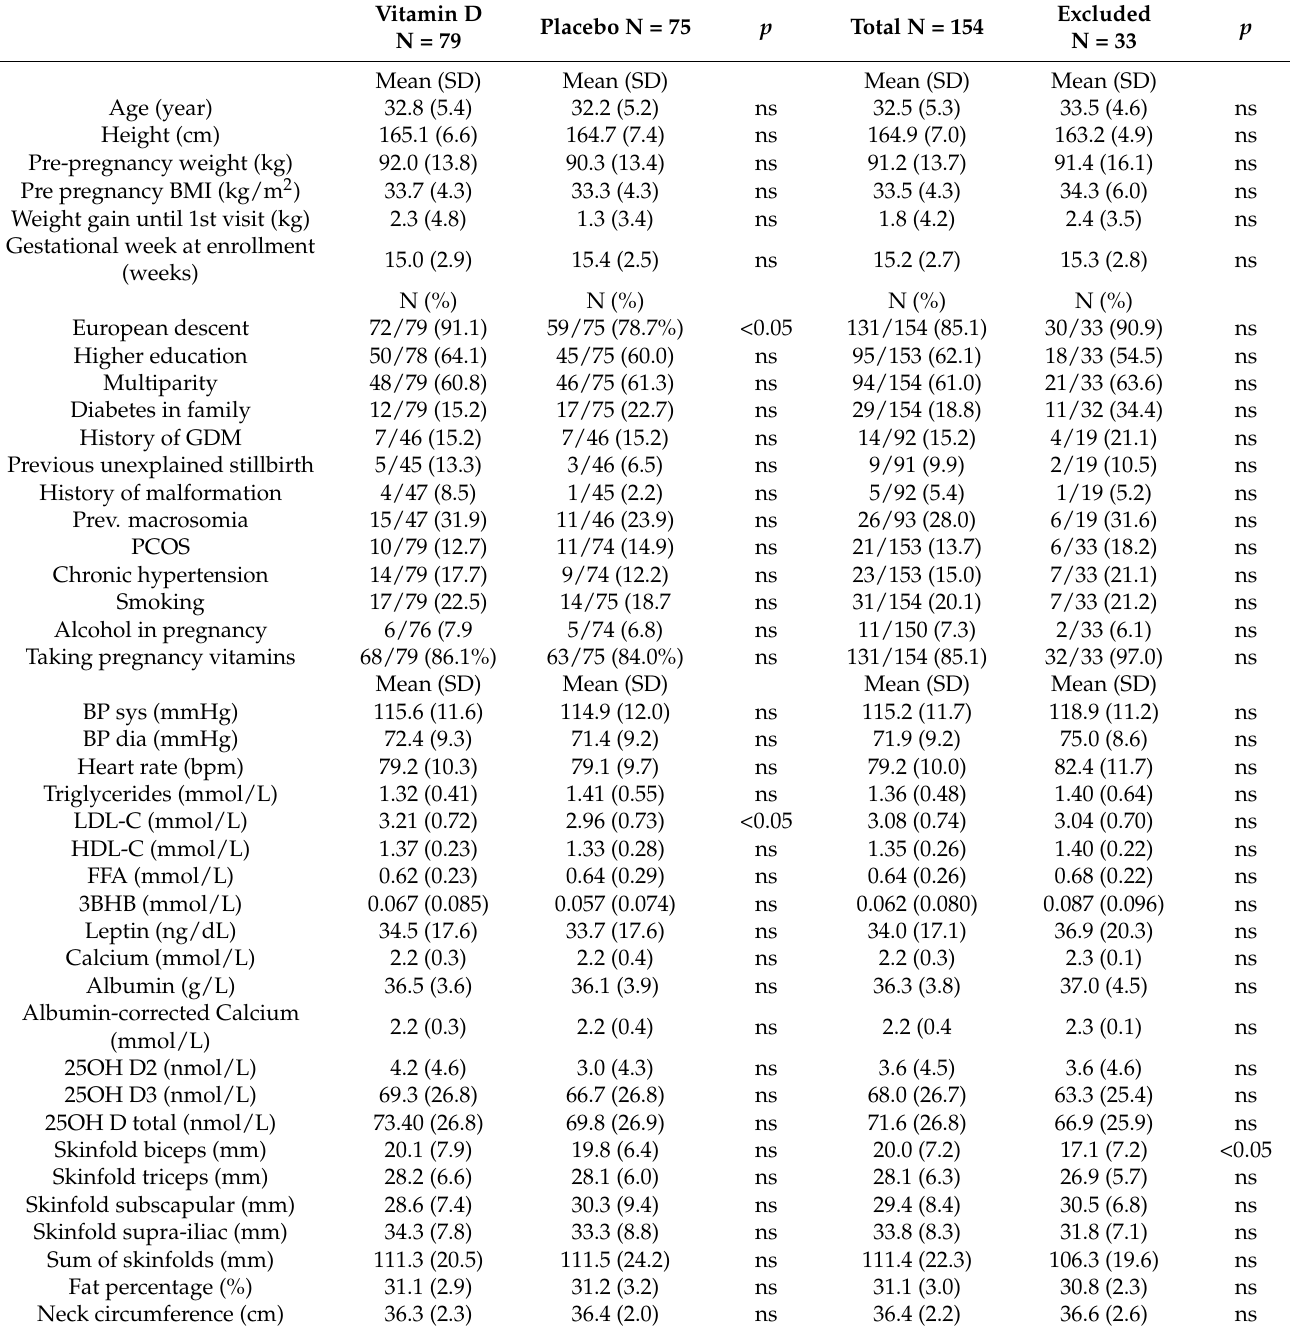
Table 1. Baseline characteristics of women participating in the DALI Vitamin D